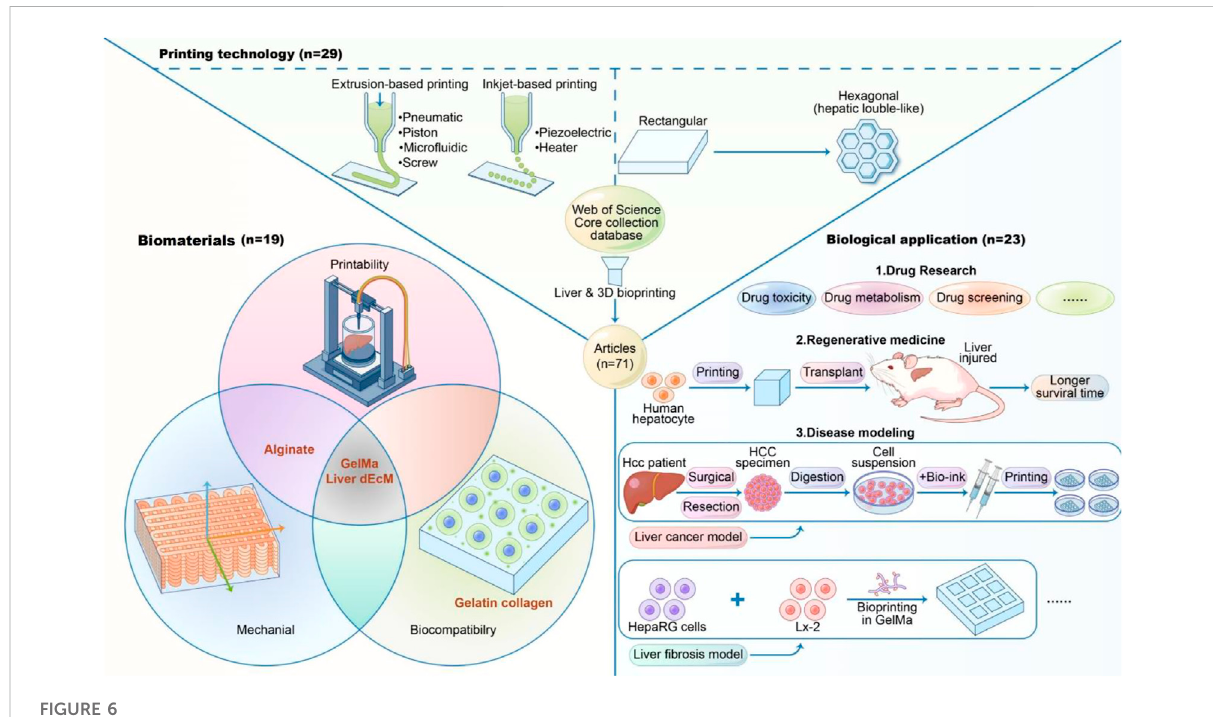
FIGURE 6 Abstract fi